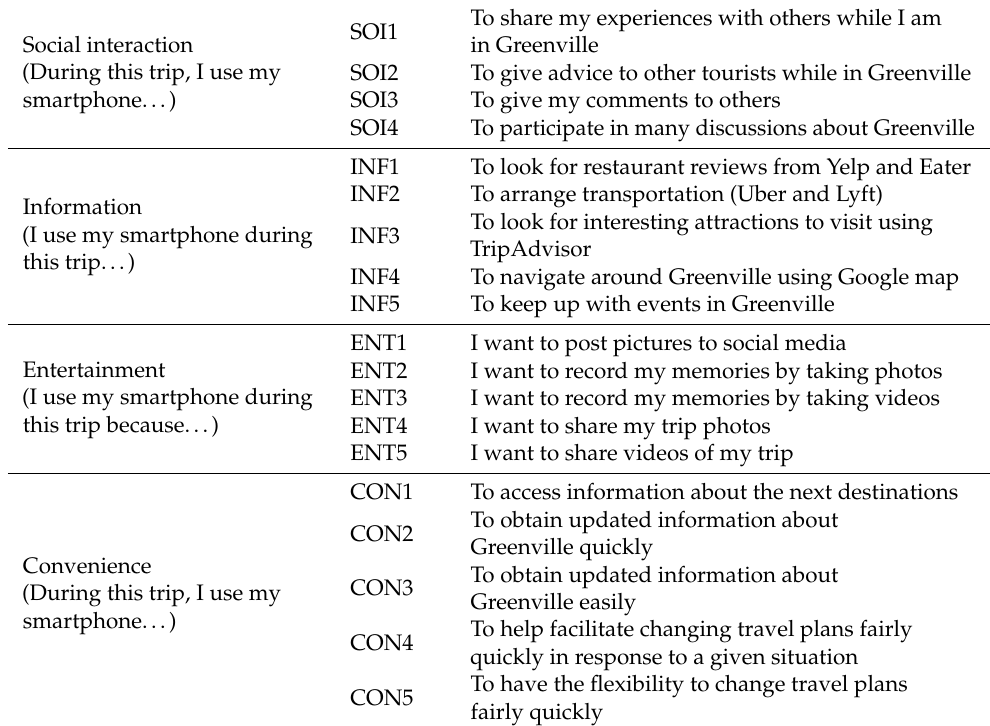
Table A1. Survey